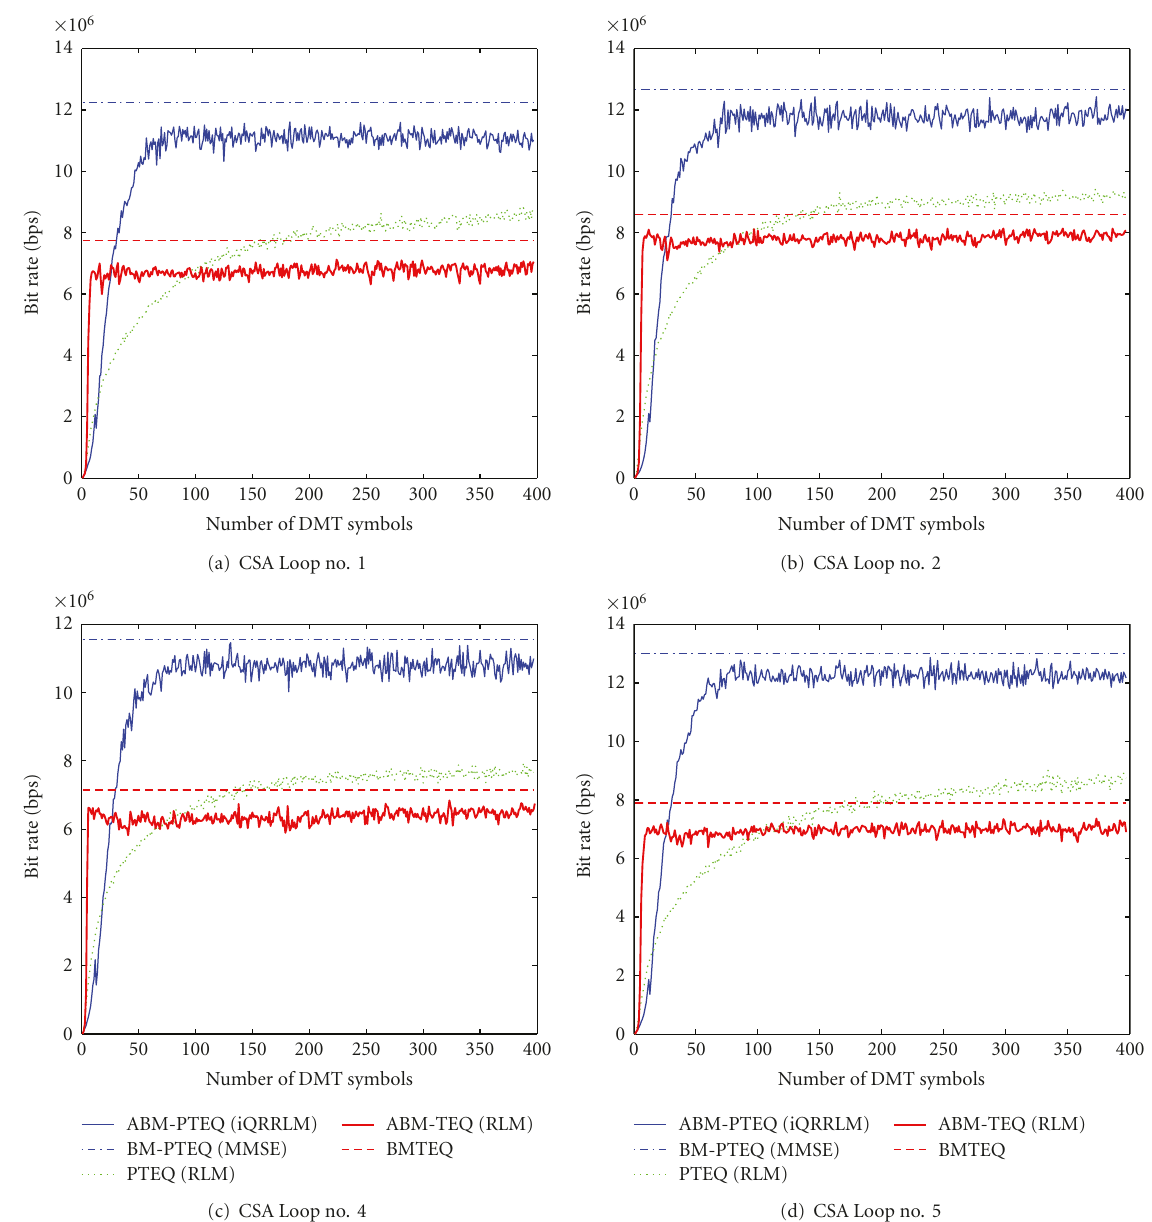
Figure 1: Learning curves of bit rate convergence of proposed adaptive iQRRLM-based BM-PTEQ (ABM-PTEQ), adaptive RLM-based PTEQ [6], and adaptive RLM-based BM-TEQ (ABM-TEQ) [12] which compared with BM-TEQ [11] and proposed MMSE-based BM- PTEQ for ADSL downstream starting at tones 38 to 255, when the samples of CSA loop are (a) CSA Loop no. 1, (b) CSA Loop no. 2, (c) CSA Loop no. 4, and (d) CSA Loop no.